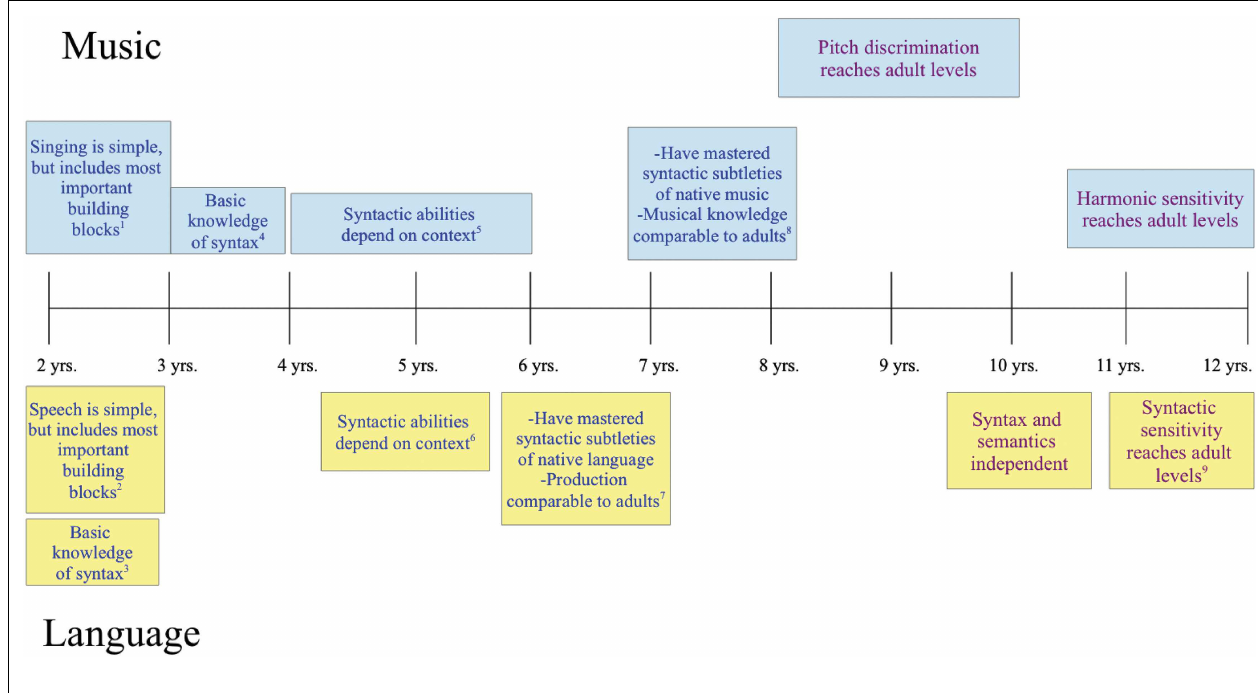
FIGURE 2 | Blue print denotes parallel development. Purple print denotes related, but not analogous development. See main text for references. (1)Two-year olds can repeat brief, sung phrases with identifiable rhythm and contour. (2) Eighteen-month olds produce two word utterances; 2year olds tend to eliminate function words, but not content words. (3)Two-year olds show basic knowledge of word order constraints. (4)Three-year olds have some knowledge of key membership and harmony and sing “outline songs.” (5) Four to six-year olds show knowledge of scale and key membership and detect changes more easily in diatonic melodies than in non-diatonic ones. Five-year olds show a typical electrophysiological